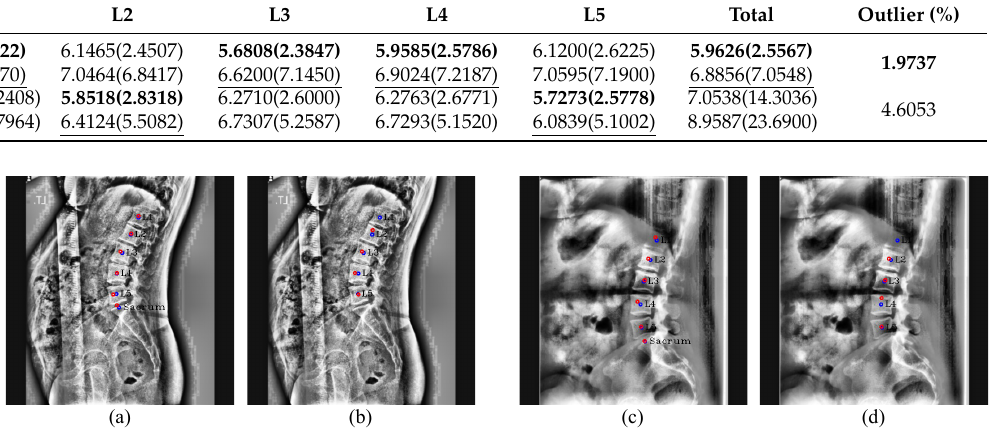
Table 10. Comparison of center detection performance between ours and Kim et al. [5]. The value having the lowest distance error for each column in (Inlier) is marked in bold and underlined for (All). L1 L2 L3 L4 L5 Total Outlier (%) Ours (Inlier)